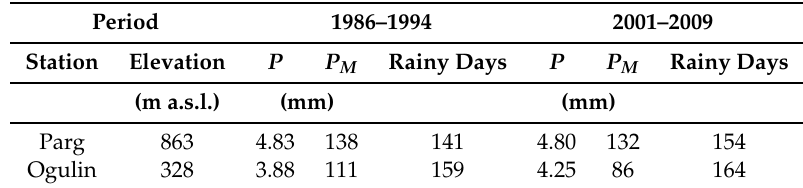
Table 2. Elevation of meteorological stations Parg and Ogulin, the average values of daily